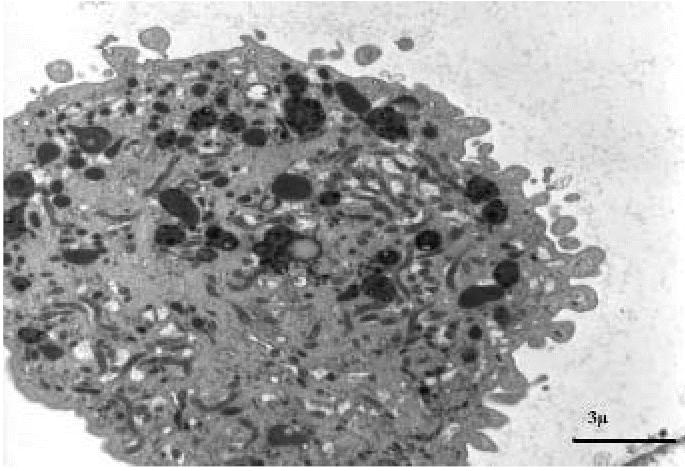
Transmission electron micrograph showing medium-sized macrophages containing both large complex inclusions and several primary lysosomes (exposed subject). Bar = 3 μm.